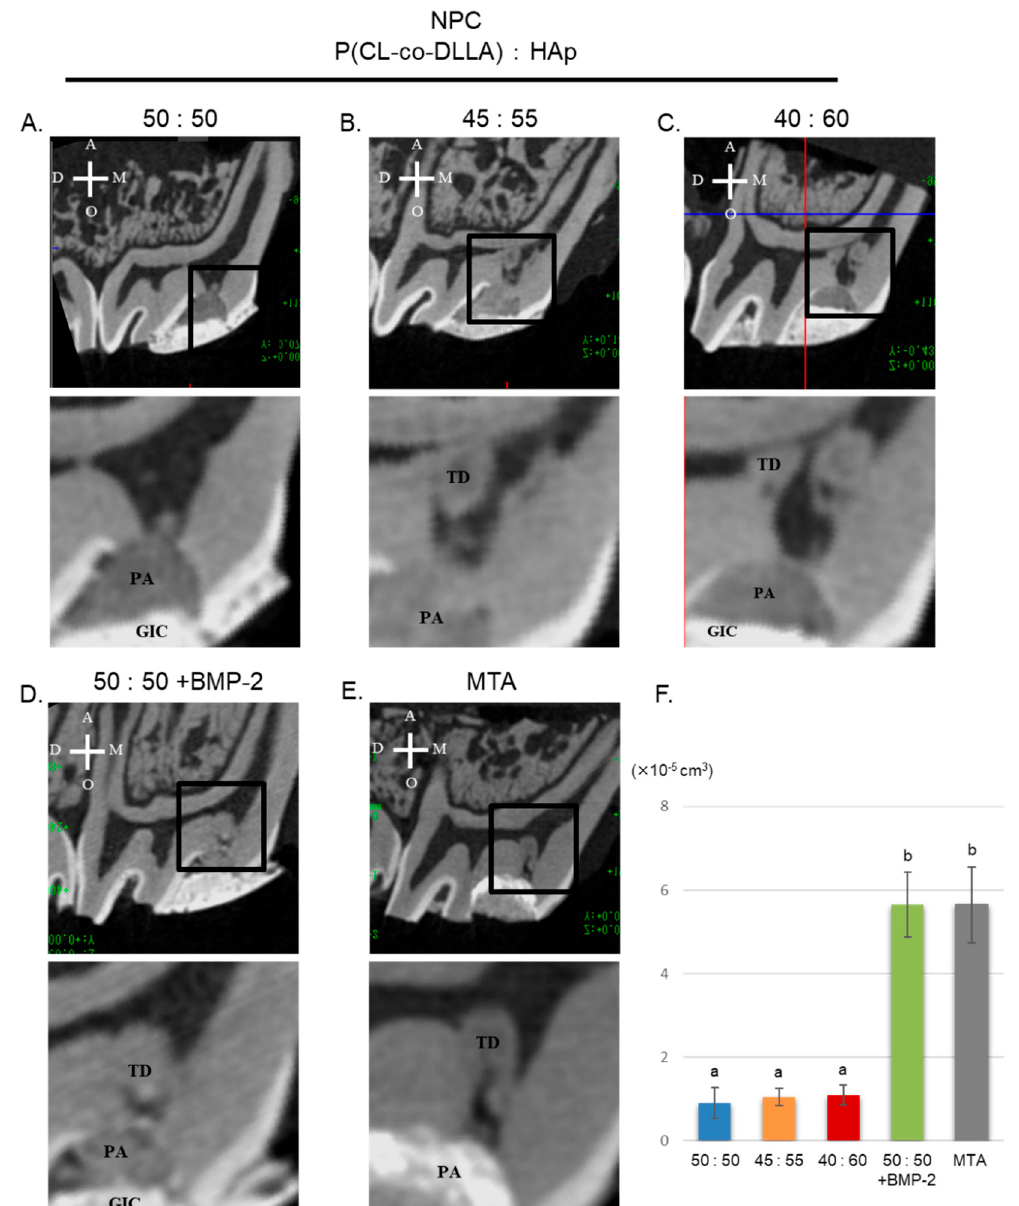
Figure 4. Micro-CT results after direct pulp capping in 4-week samples. Representative sagittal micro-CT images of tertiary dentin induced by several ratios of HAp NPC, NPC with BMP-2, and MTA are shown ( A – E ). The area surrounded by the black box is enlarged and shown at the bottom respectively). Tertiary dentin formation induced by NPC (50:50) with BMP-2 and MTA showed similar characteristics in dentin volume (DV) ( F ). A = apical, O = occlusal, M = mesial, D = distal, TD = Tertiary dentin, GIC = glass ionomer cements, PA = Pulp capping agent, P = pulp.